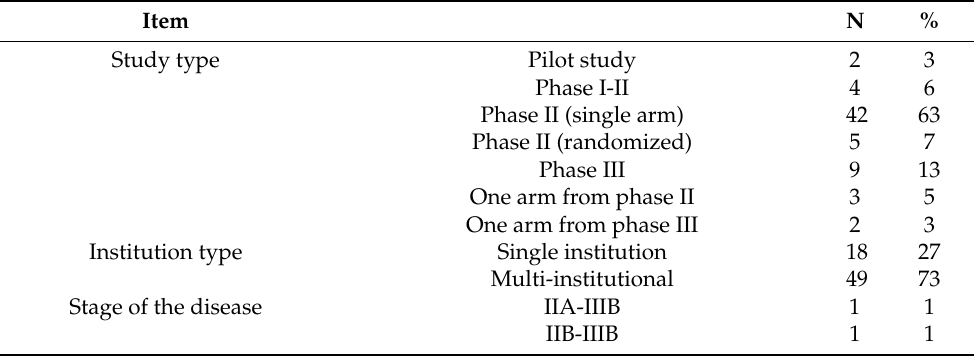
Table 1. Characteristics of eligible studies and